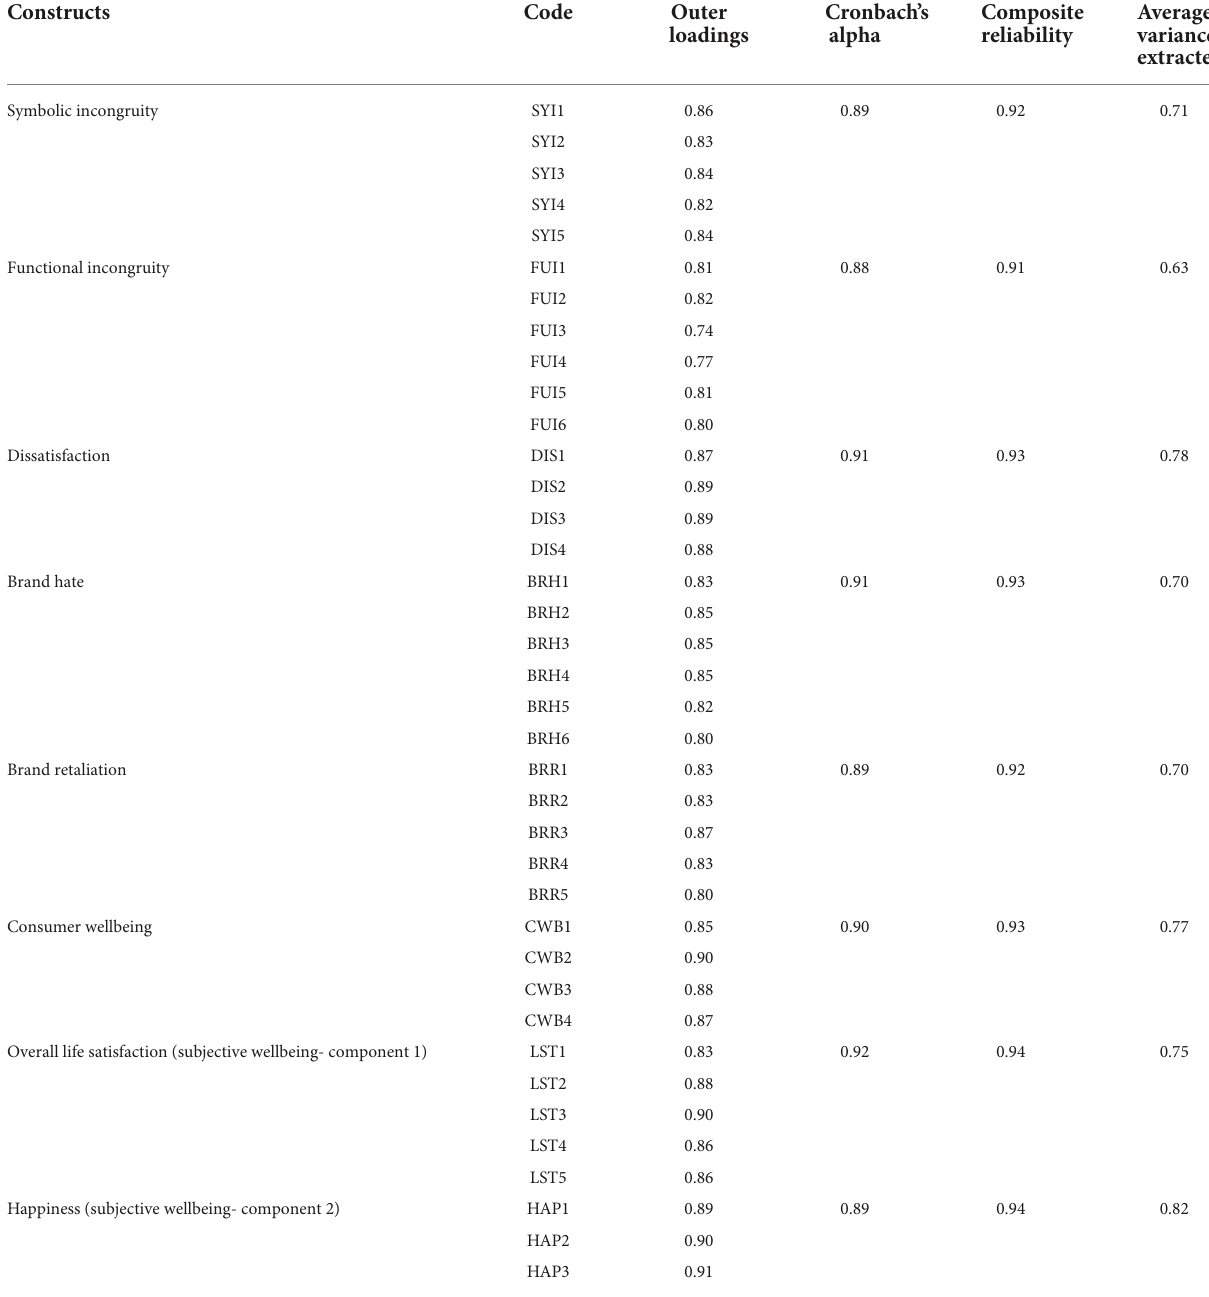
TABLE 2 Results of the measurement